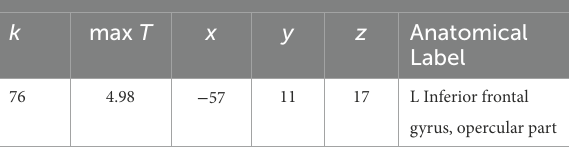
TABLE 2 Listing of anatomical structures with statistically significant group effect of VWFA gPPI connectivity – reading words vs. reading nonwords after RT-related connectivity modulation effects were regressed out (words<nowords above and over RTs only, no effects of words>nonwords above and over RTs were